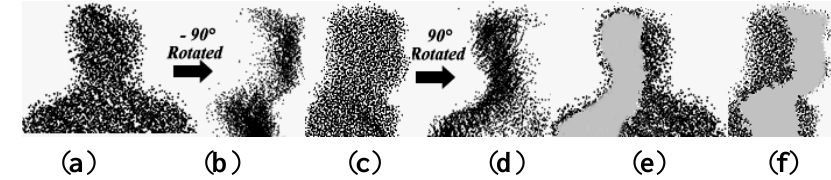
Figure 7. Mixed head point cloud: ( a ) 0° head view; ( b ) −90°rotated; ( c ) 90° head view; ( d ) 90° rotated; ( e ): overlapped areas of (a) and (d); and ( f ) overlapped areas of (b) and